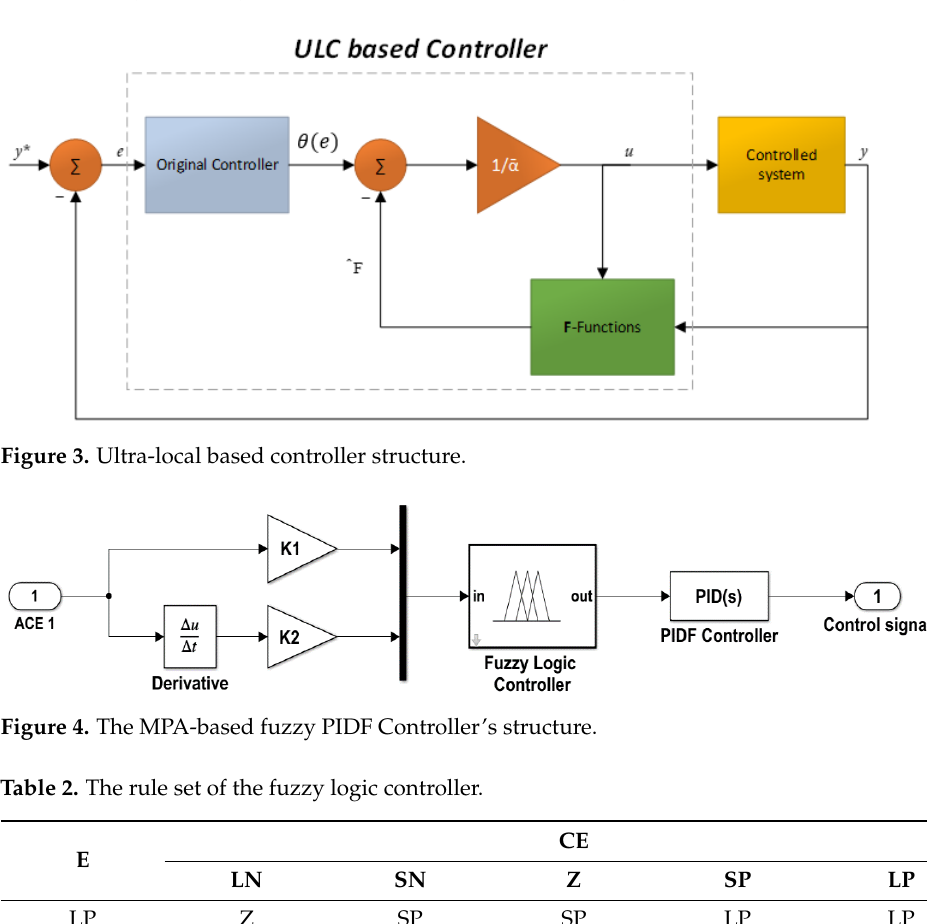
Table 2. The fuzzy logic controller's rule set.